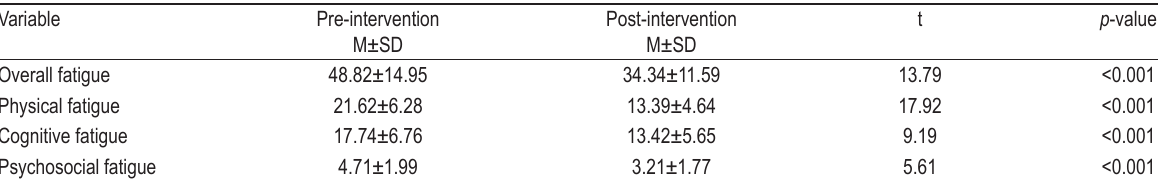
TABLE 2. Pre‑ and post‑intervention fatigue levels (N=95)